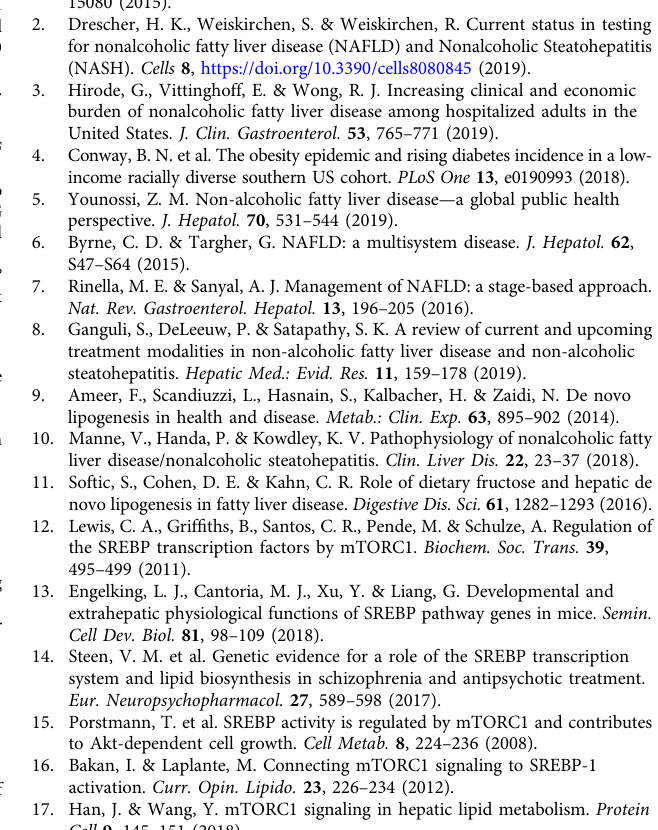
Fig. 8 PPDPF overexpression reduces HFD-induced hepatic steatosis. Body weight ( a ) and liver weight ( b ) of AAV8-con and AAV8-PPDPF mice fed a chow diet of HFD for 12 weeks ( n = 4 for each group). Mean ± SEM, n.s (not signi fi cant), * p = 0.014 ( a ); n.s (not signi fi cant), ** p = 0.01 ( b ) by two-tailed unpaired Student ’ s t test. The triglyceride (TG) ( c ) and nonesteri fi ed fatty acid (NEFA) ( d ) levels in the livers of AAV8-con and AAV8-PPDPF mice at the end of 12-week HFD feeding ( n = 4 mice for each group). Mean±SEM, n.s (not signi fi cant), ** p = 0.004 ( c ); n.s (not signi fi cant), *** p = 0.0003 ( d ) by two-tailed unpaired Student ’ s t test. e Representative H&E and Oil Red O staining of liver sections from AAV8-con and AAV8-PPDPF mice after 12-week HFD feeding. Scale bars, 100 um. GTTs ( f ) and ITTs ( g ) were performed in AAV8-con ( n = 3) and AAV8-PPDPF ( n = 3) mice fed a chow diet or AAV8- con ( n = 3) and AAV8-PPDPF ( n = 4) mice on HFD diet for 10 weeks and 11weeks. Mean ± SEM. See Supplementary Data 2 for statistics. h The mRNA levels of lipogenic genes in the livers of AAV8-con ( n = 4) and AAV8-PPDPF ( n = 4) mice on HFD diet. Mean ± SEM, SREBP1 : * p = 0.018, FASN : * p